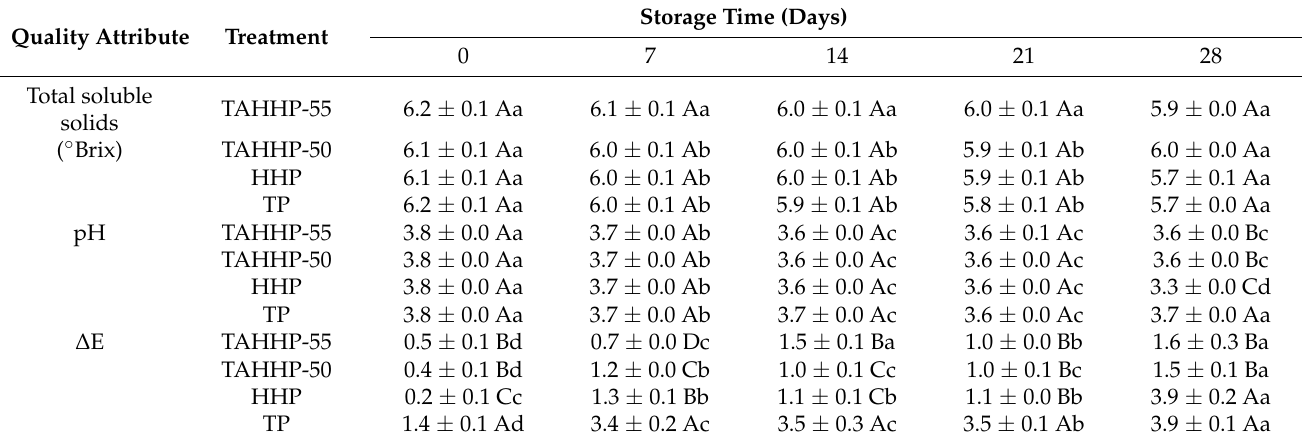
Table 4. Physicochemical characteristics of aronia juice during 28 days of storage at 4 ◦